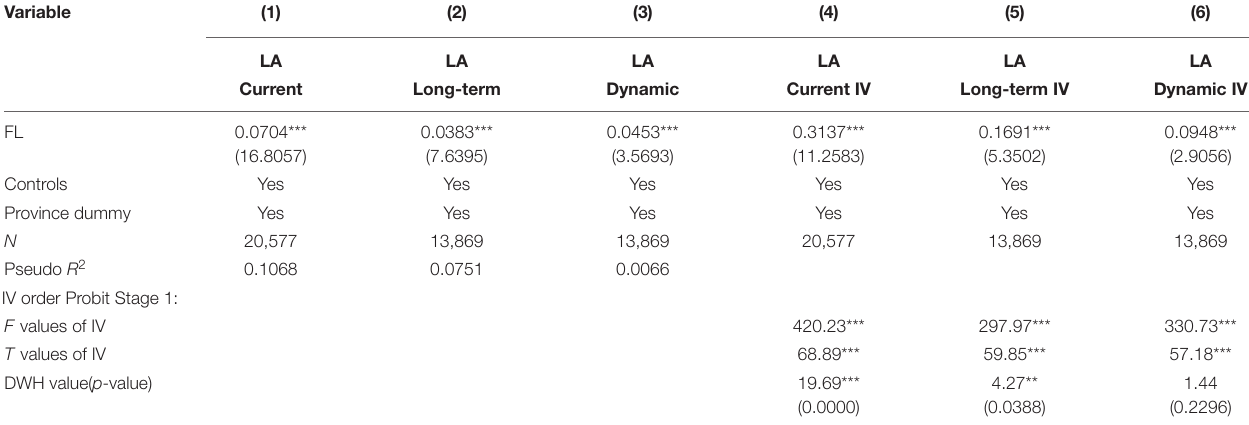
TABLE 5 | The impact of financial literacy on limited